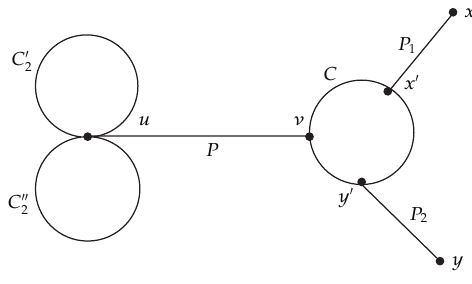
Figure 5: Illustration for Case 3 of Lemma